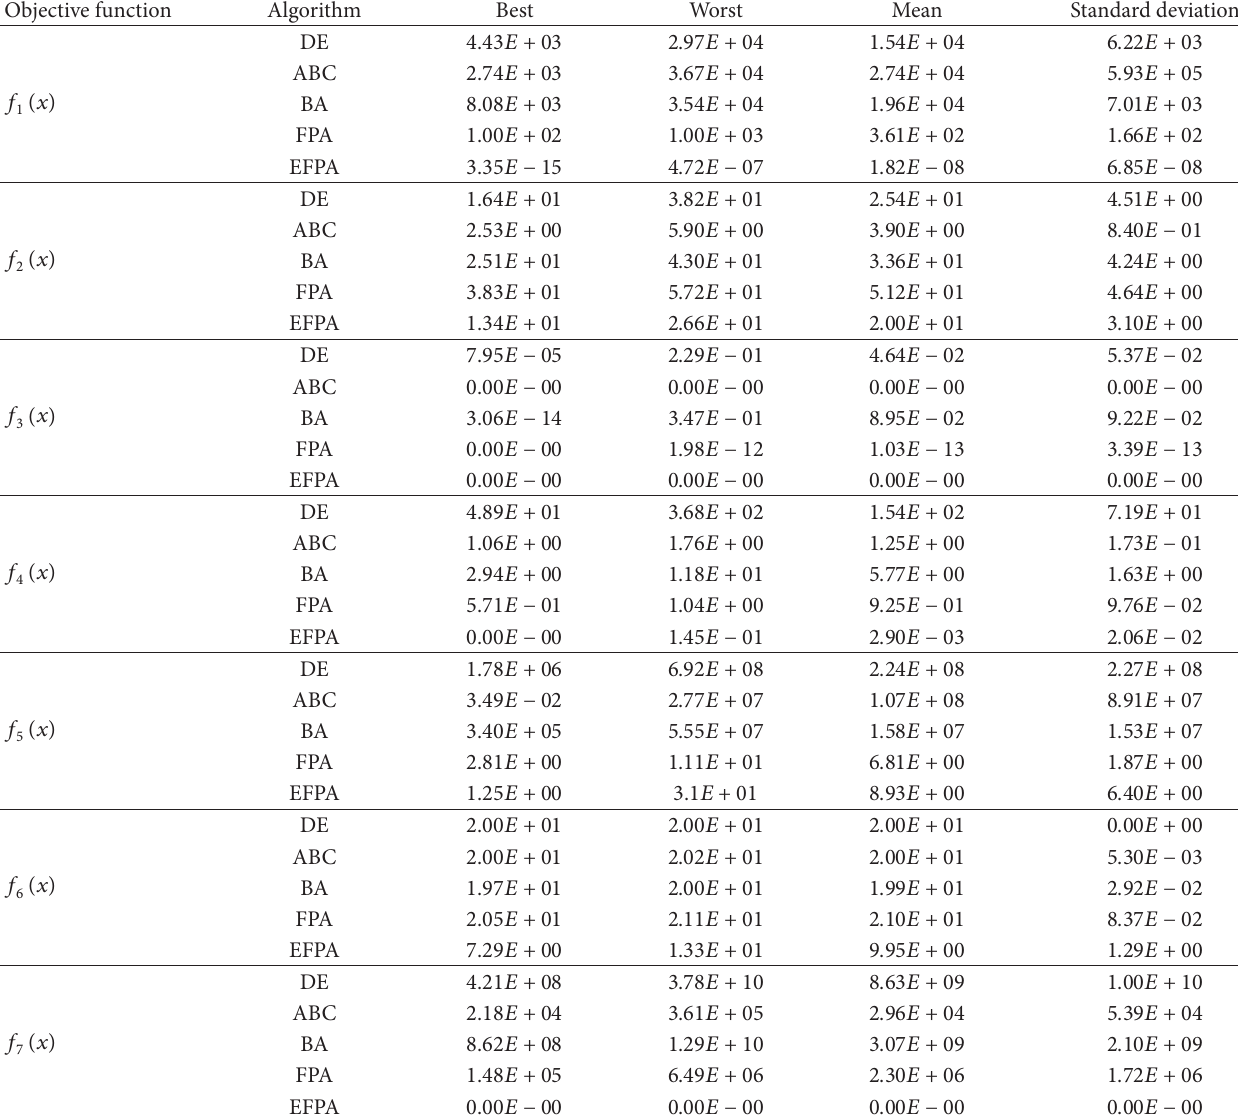
Table 3: Comparison of results for various test functions.